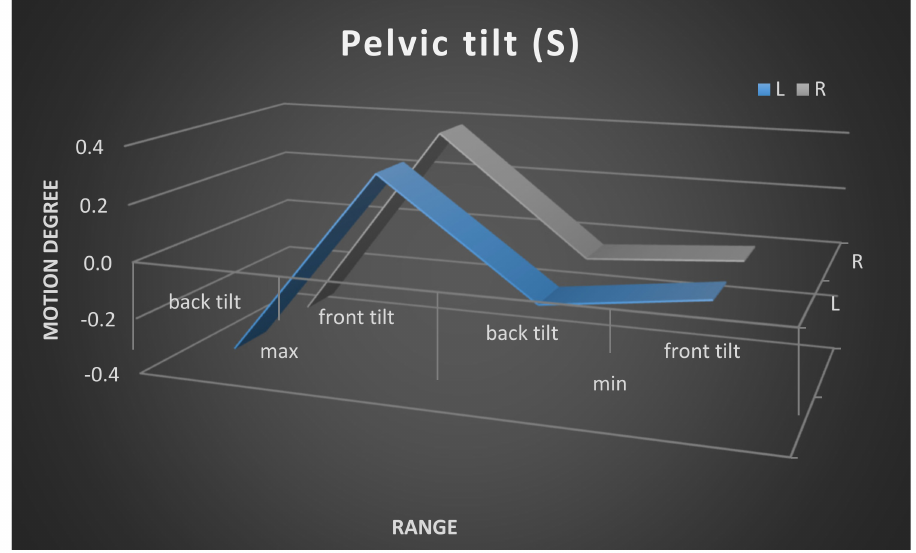
Figure 3. Pelvic tilt maximum and minimum range of movement. Left and right side comparison.